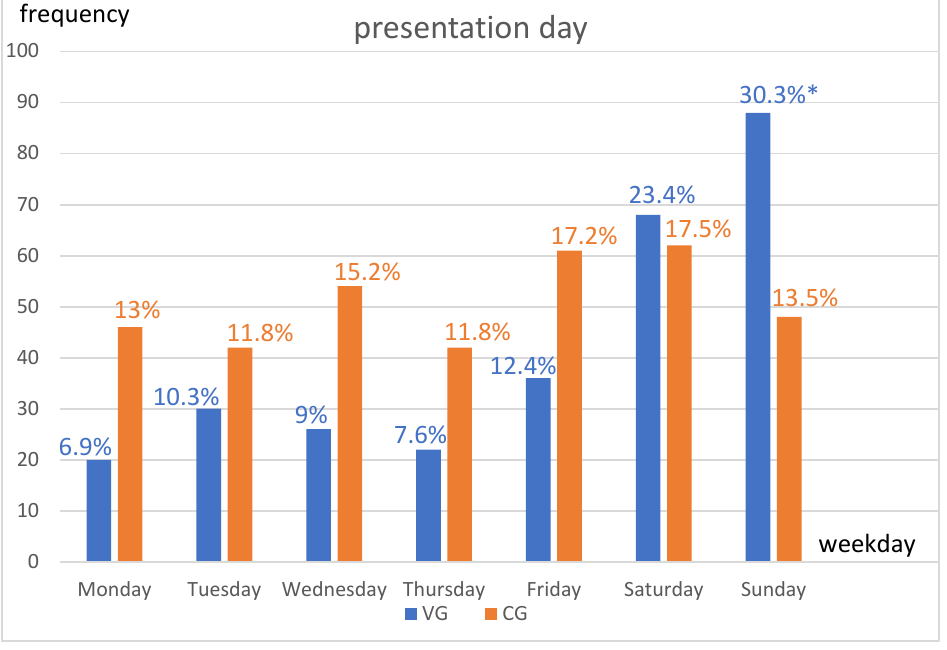
Figure 1. Shown are frequencies (including percentages) of presentations by day of week in direct comparison of groups [blue = violence group (VG); orange = comparison group (CG)]. The chi-square test was used for the statistical analysis. * p < 0.05.